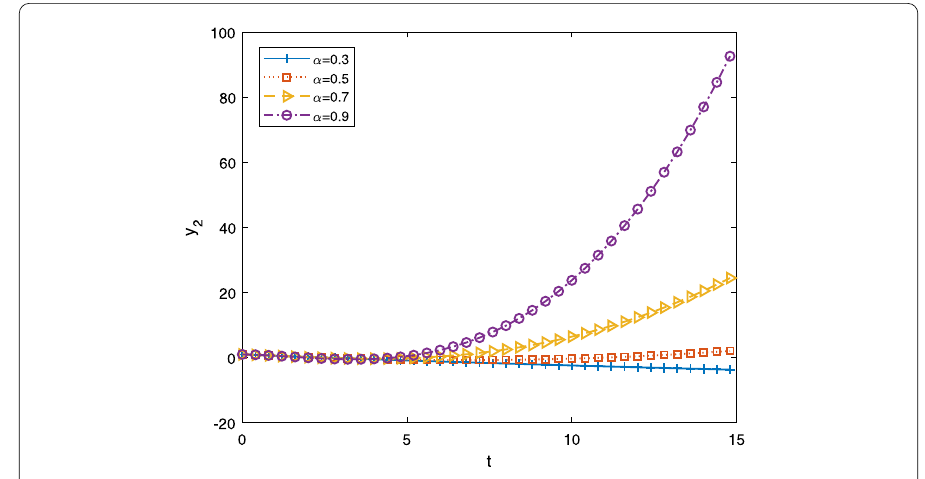
Figure 4 Numerical solution of Example 8.3 for the second component with N = 10